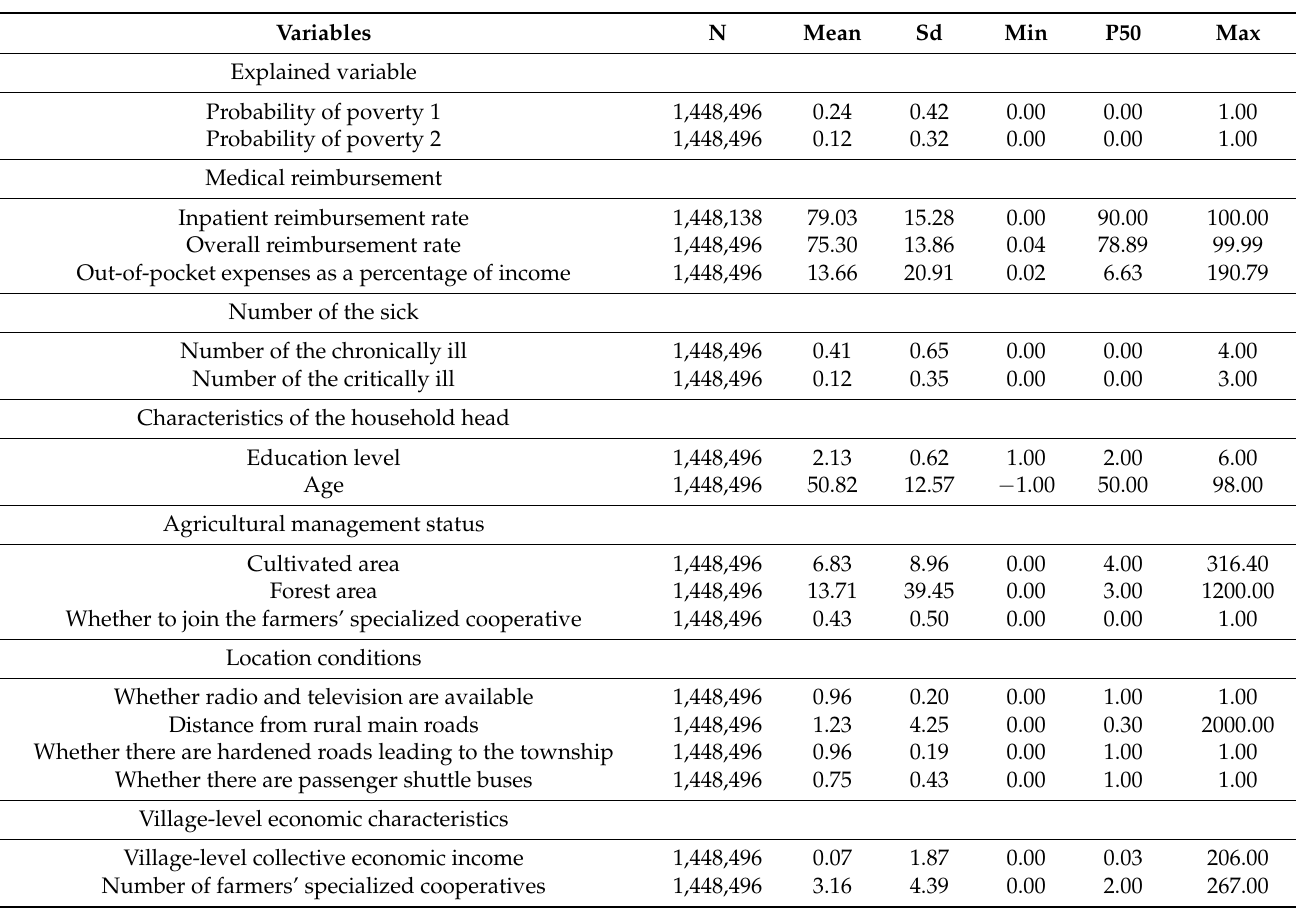
Table 2. Descriptive Statistics of